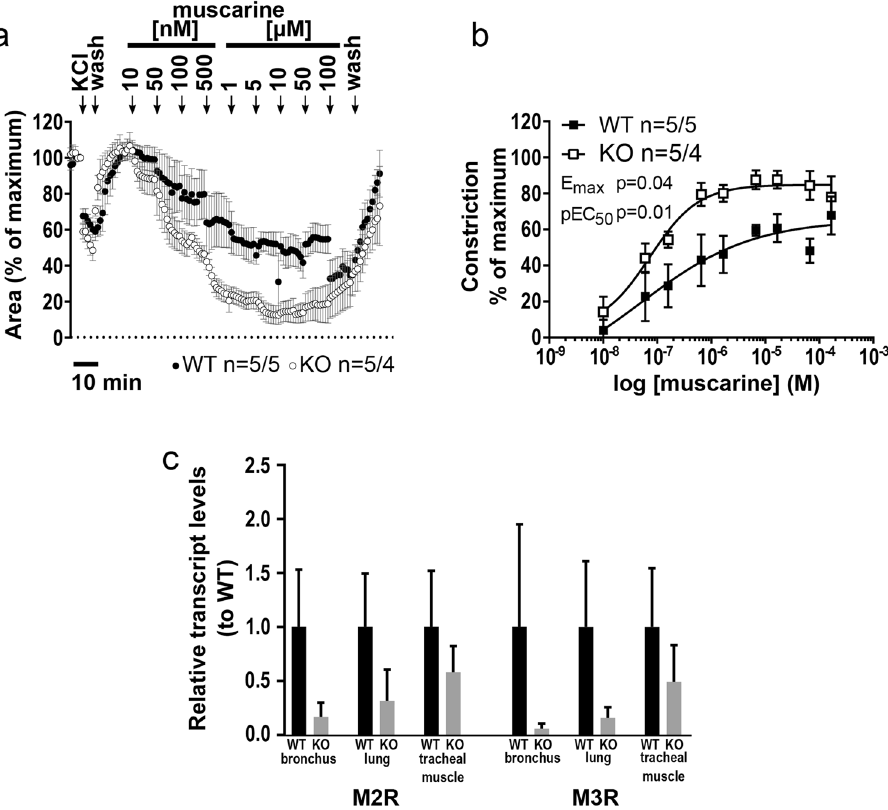
Figure 7. Bronchoconstrictor response to muscarine of peripheral bronchi from cav-3 + / + (WT) and cav-3 − / − (KO) mice. Videomorphometric analyses of PCLS, depicted are changes in the luminal area. Data are presented as mean of number of bronchi (n)/number of animals ± SEM. ( a ) Muscarine-mediated concentration- dependent decreases in the luminal airway area in cav-3 + / + and cav-3 − / − mice. KCl (60 mM) was applied as a viability control for 5 min, and the pre stimulus value was set as 100%. In response to different concentrations of muscarine (10 nM–100 µ M) a dose dependent continuous contraction was observed in bronchi of cav- 3 + / + and cav-3 − / − mice. ( b ) Depicted are the sigmoidal concentration-response curves (plotted using the Hill equation) of concentration versus luminal area reduction of peripheral bronchi of cav-3 + / + and cav-3 − / − mice. The Student’s unpaired t-test was used to analyze values for E max and pEC 50 . Bronchi of cav-3 − / − mice responded with a stronger contraction (p ≤ 0.05) and a difference in pEC 50 (p ≤ 0.05). ( c ) Relative transcript levels of muscarinic acetylcholine receptor subtypes 2 and 3 (M2R and M3R) genes standardized on internal β -microglobulin ( β -MG) levels. Results for the cav-3 − / − tissues are presented relative to the results for cav-3 + / + tissues set to 1 to appreciate its potential differences independent from individual assay performance. Data are presented as mean ± SEM (Student’s t-test, * p < 0.05; n = 4 mice per genotype). No differences in M2R and M3R expression were observed between cav-3 − / − and cav-3 + / + tracheal SM, extrapulmonary bronchi and lung (with intrapulmonary